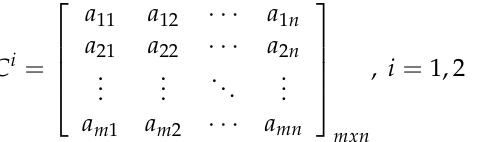
Let I be input and O output, then C I is the input independent variable and C O is the output dependent